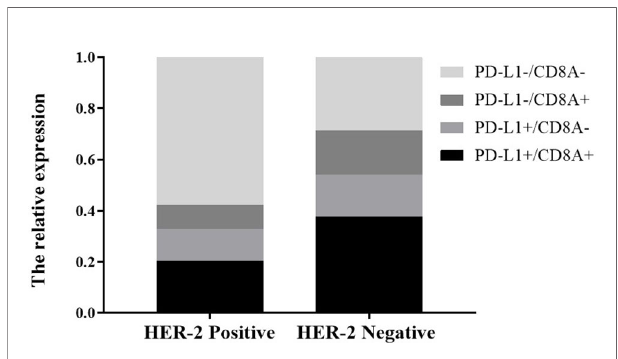
FIGURE 4 | Effect of HER-2 status on tumor immune typing.